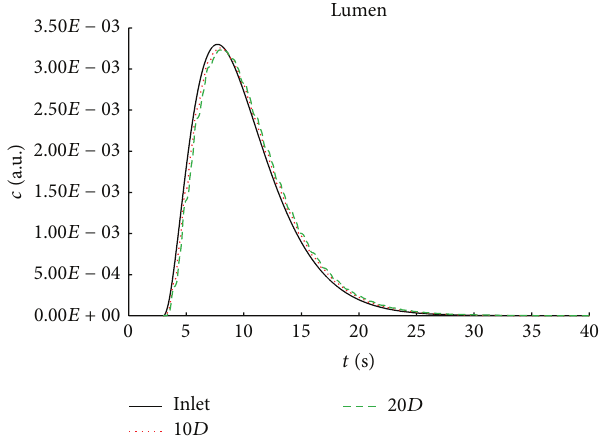
Figure 2: The concentration-time curves at inlet, 10𝐷 , and 20𝐷 in the model with arterial transmural